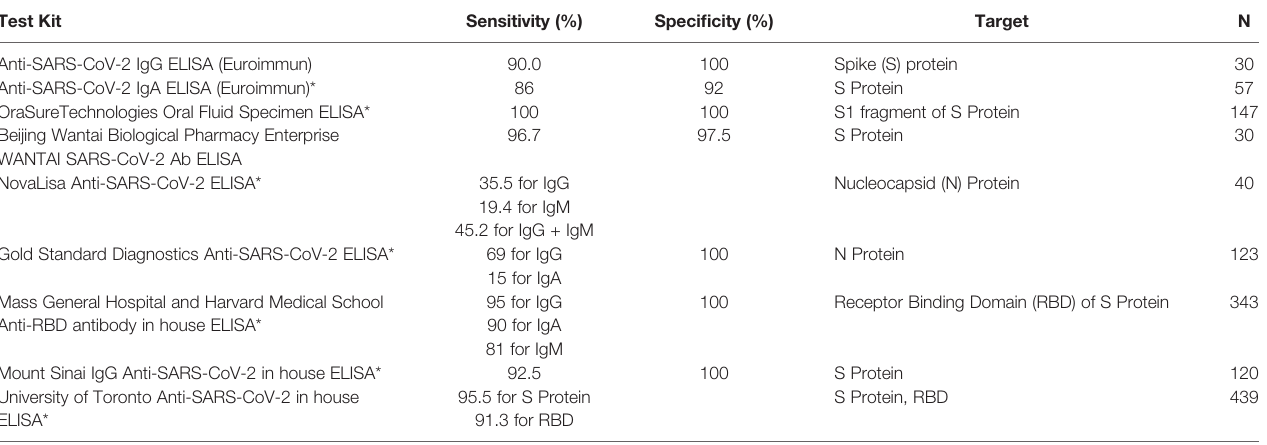
TABLE 1 | Summary and statistics of reviewed EUA-approved, non-EUA approved, and in-house ELISA